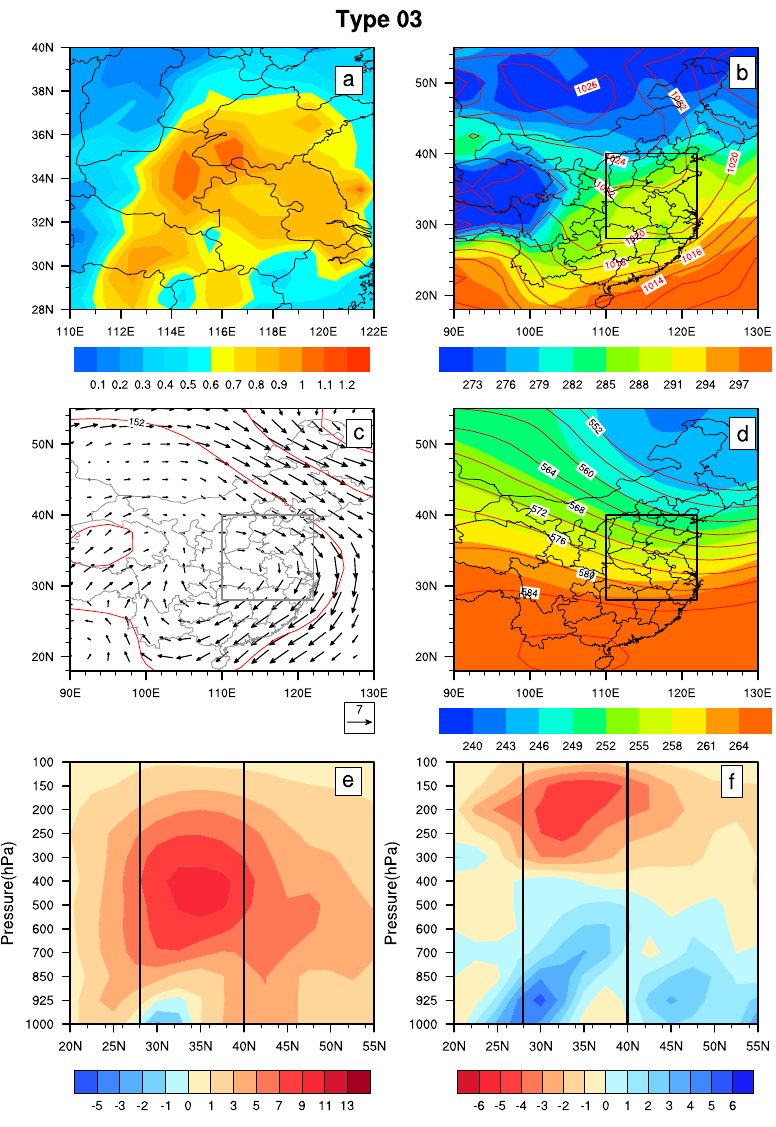
Figure 10. As in Fig. 8 but for Type 3